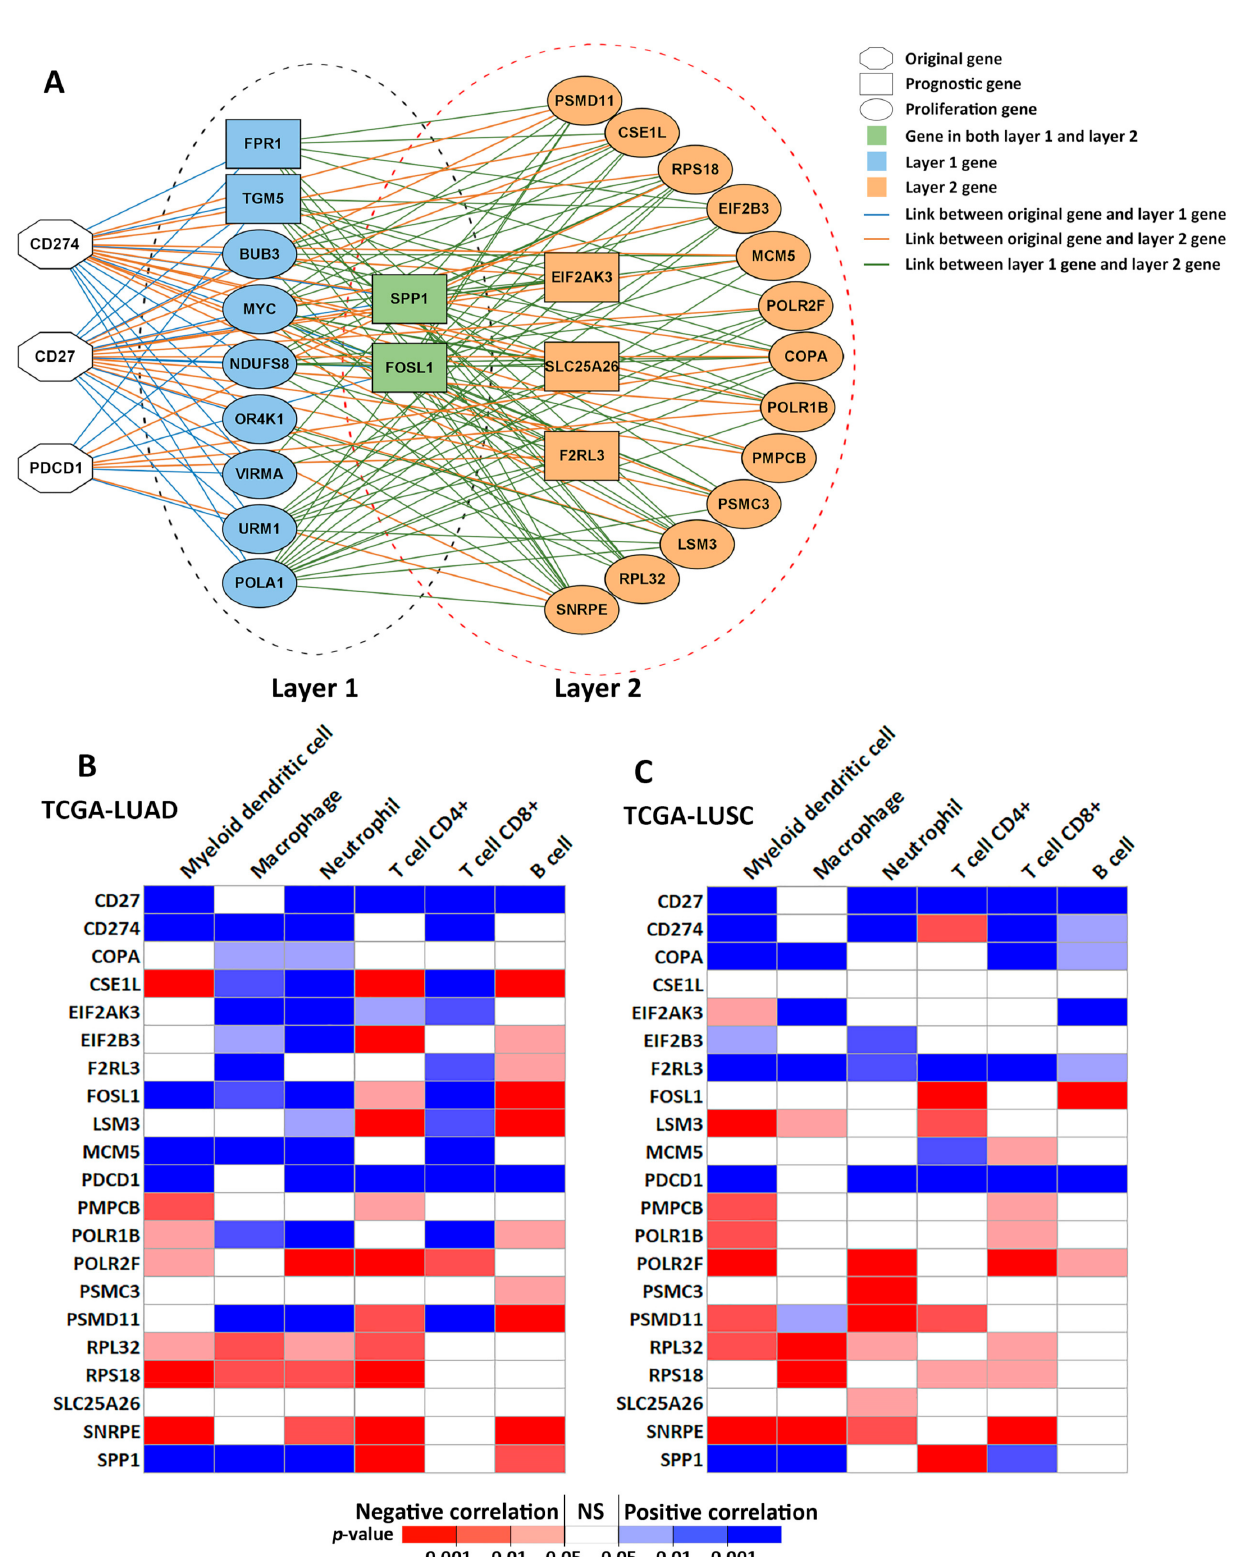
Figure 4. CD27 , PD1 and PDL1 immune-omics network in NSCLC. ( A ) CD27 , PD1 , and PDL1 multi-omics association network. ( B ) The correlation of immune infiltration level with gene expression in TCGA-LUAD patients ( n = 515) estimated with TIMER. ( C ) The correlation of immune infiltration level with gene expression in TCGA-LUSC patients ( n = 501) estimated with TIMER. NS: not